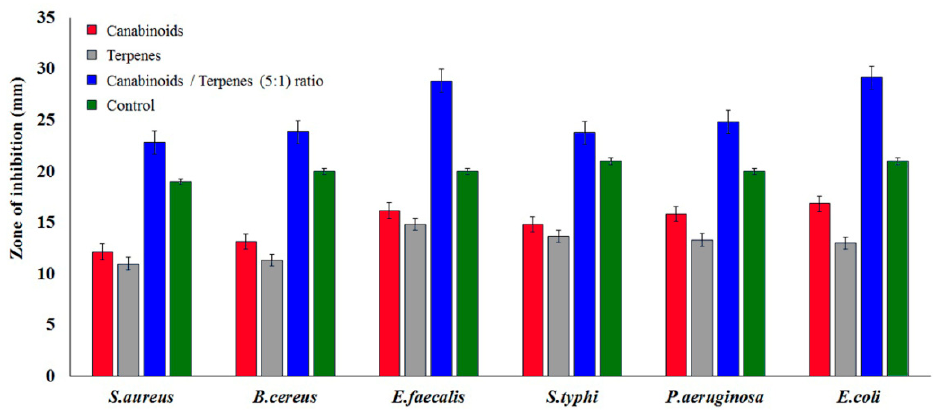
Figure 1. Synergistic antimicrobial activity of cannabinoids:terpenes (5:1 ratio).